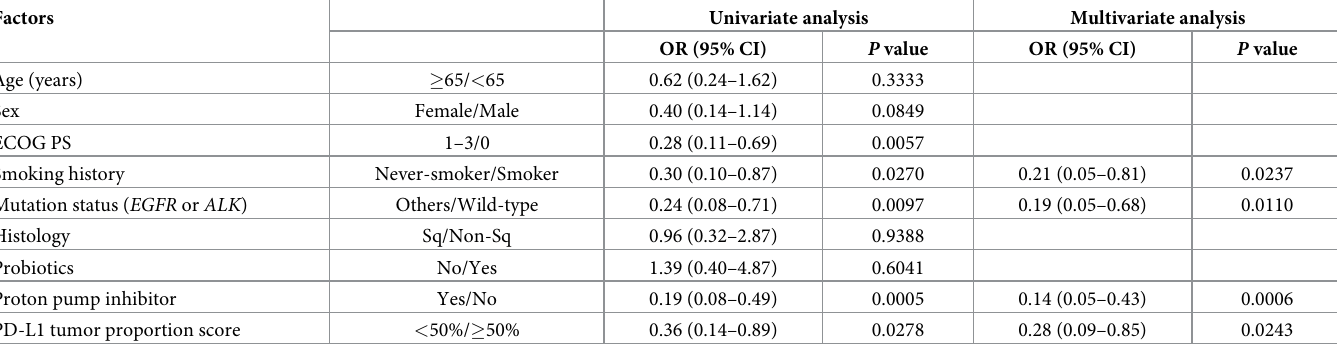
Table 4. Inverse probability of treatment weighting-adjusted univariate and multivariate analyses of the relationship between disease control (CR + PR + SD) and clinical factors.